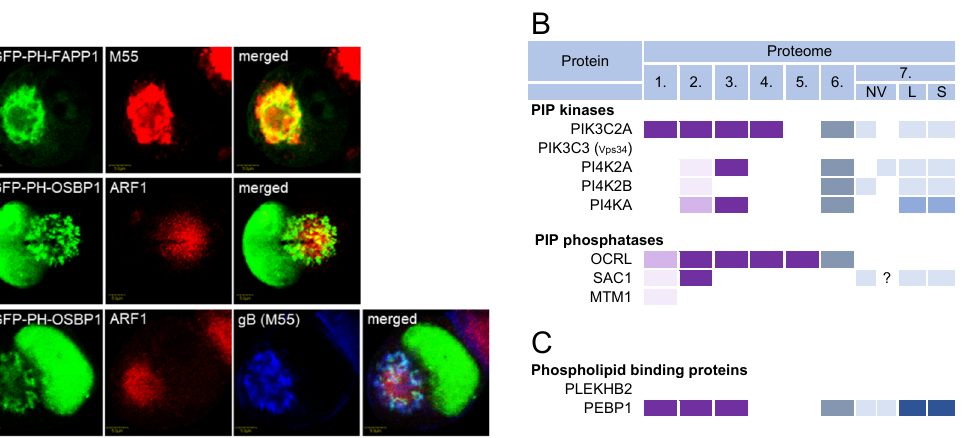
Figure 8. Phosphoinositide codes in CMV-infected cells and virions. ( A ) Images of MCMV-infected cells showing the distribution of the PI(4)P-binding modules (EGFP-PH-FAPP1 and EGFP-PH-OSBP1), Arf1, and viral glycoprotein B (M55). Cells were stained 48 h postinfection as previously described [33]. PIP kinases and phosphatases ( B ) and phospholipid-binding proteins ( C ) identified in five proteomes of HCMV virion preparation (proteomes 1–5), proteome of HSV-1 heavy particles (proteome 6), and extracellular nanoparticle (proteome 7), as described in Figure 3. A complete list of all kinases and phosphatases is shown in Figure S5.